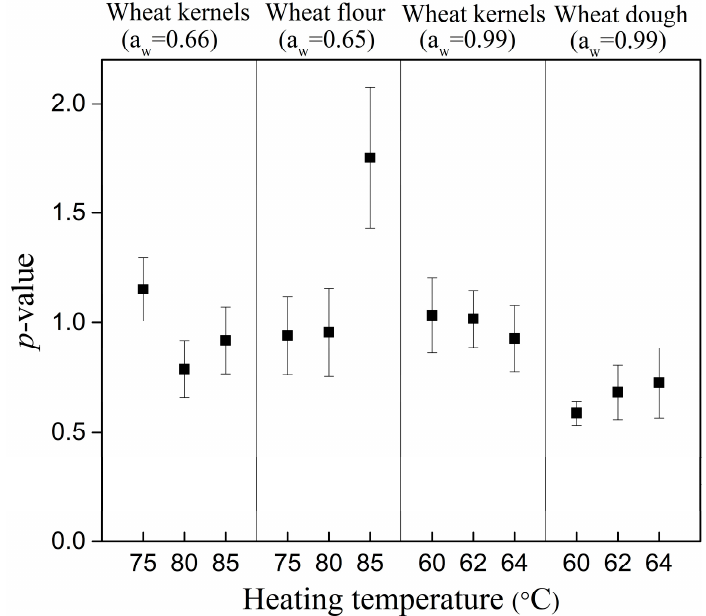
Figure 6. The shape parameter p and associated 95% confidence interval as a function of heating temperature for E. faecium in food matrices with different physical structures.